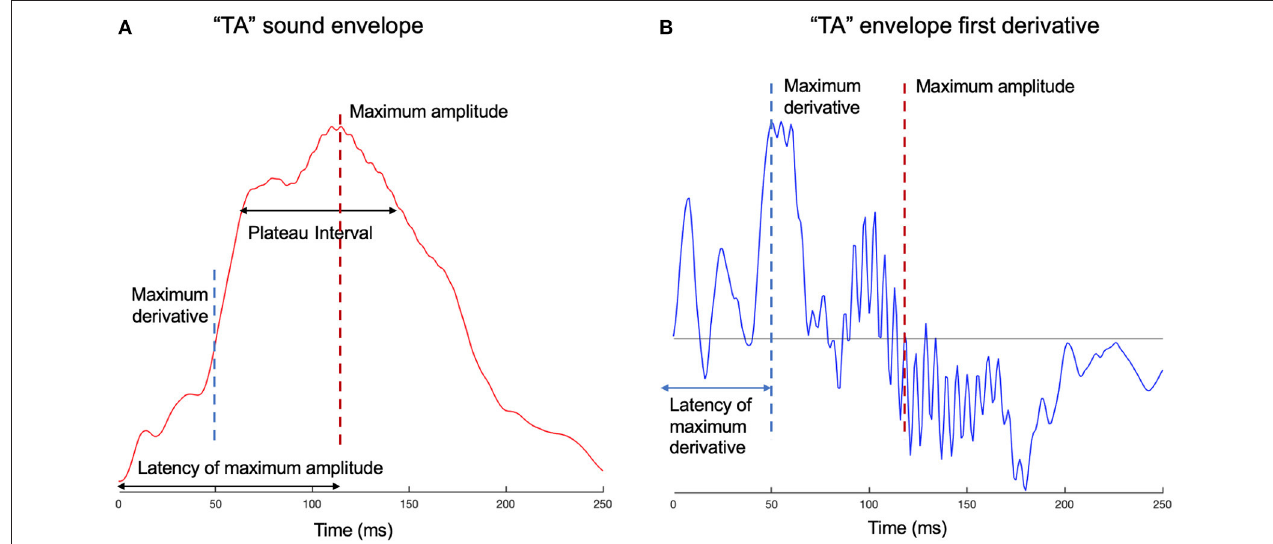
FIGURE 1 | Edge measures examples for syllable “ta.” (A) The smooth sum of narrowband envelopes is given for syllable “ta.” The amplitude of the envelope is plotted against time. On the time axis are marked the latencies of the maximum amplitude (MA) and maximum derivative (MD), which correspond to their relevant landmarks on the amplitude axis. The plateau of the syllable peak is also shown, measured as the time from 80% of the MA on the ascending slope to 80% of the MA on the descending slope. The maximum derivative can be considered a marker for the consonant-vowel transition, which is a temporal interval, but for this particular syllable, delineates between /t/ and /a/ phonemes. (B) The first derivative of the envelope is shown for syllable “ta.” The maximum derivative, its latency, as well as the maximum amplitude, are shown on the